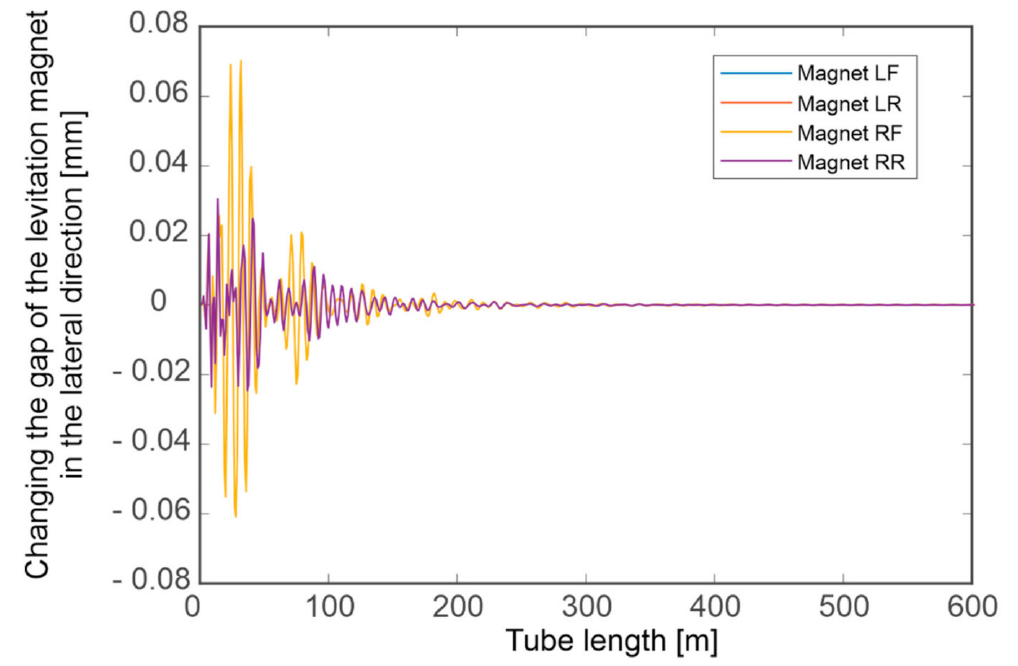
Figure 10. Change in the gap width on the levitation magnet in the lateral direction resulting from the capsule speed of 2000 km / h.